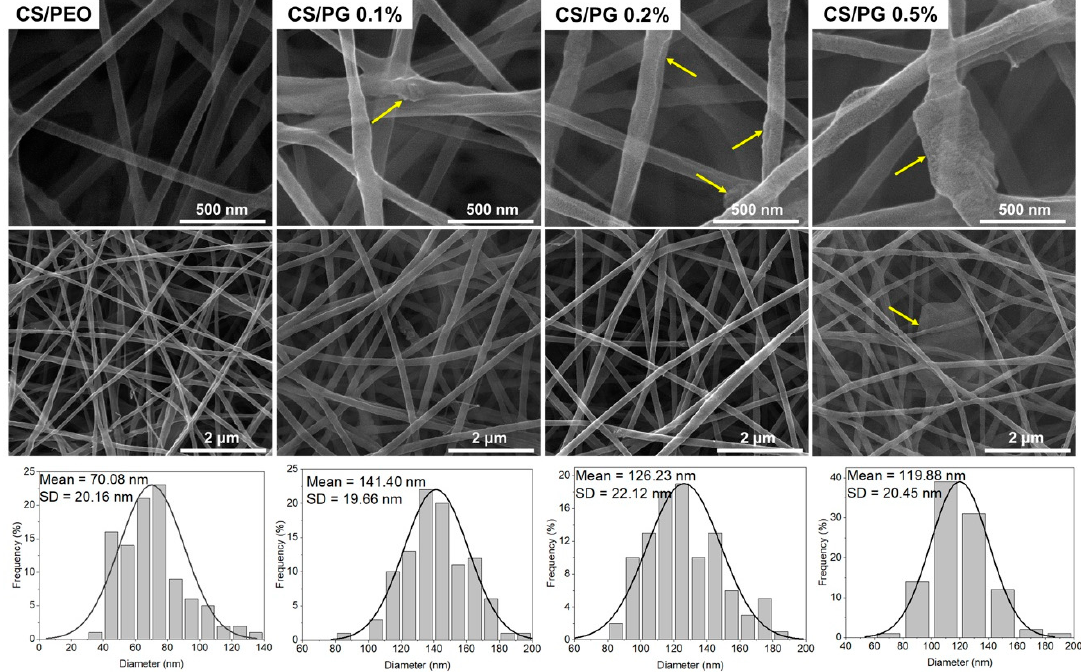
Figure 4. SEM images and the corresponding size distribution graphs of CS/PEO electrospun scaffolds as well as CS/PG 0.1%, CS/PG 0.2%, and CS/PG 0.5% composite scaffolds with nanofibrous architecture (the images are presented at 50,000×, 200,000× magnification).